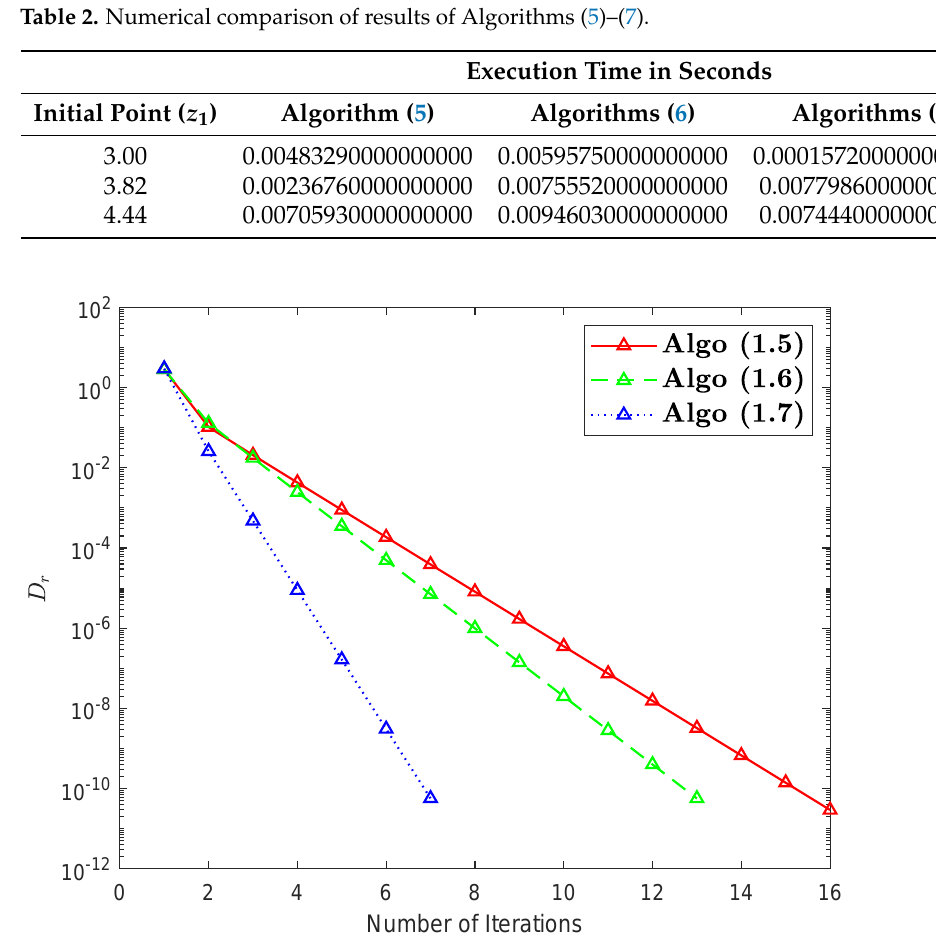
Figure 1. A graphical comparison of Algorithms (5)–(7), where z 1 =